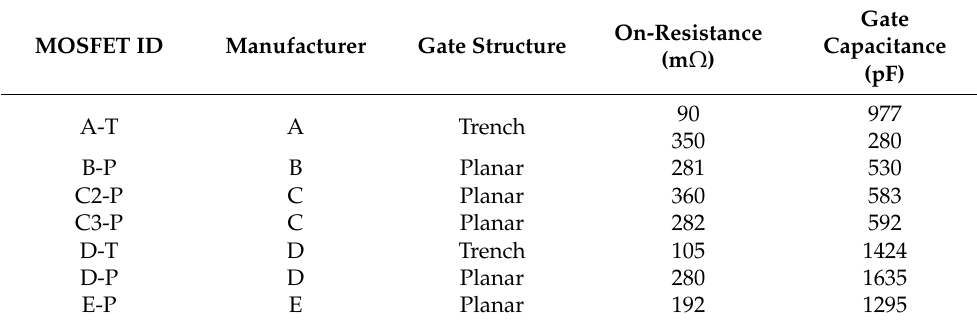
Table 1. On-resistance and measured gate capacitance at V G = 18 V for 1200 V commercial power MOSFETs.